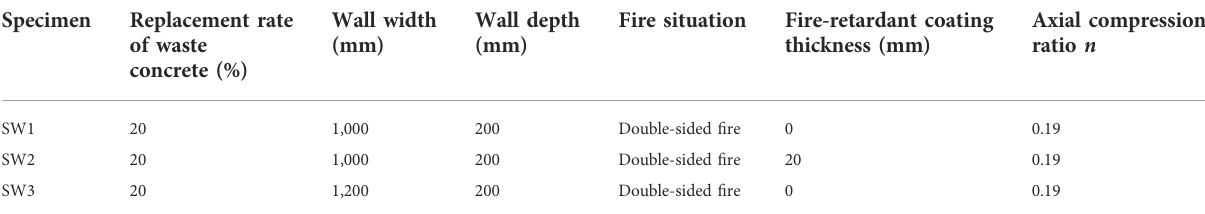
TABLE 1 Detailed parameters of specimens.